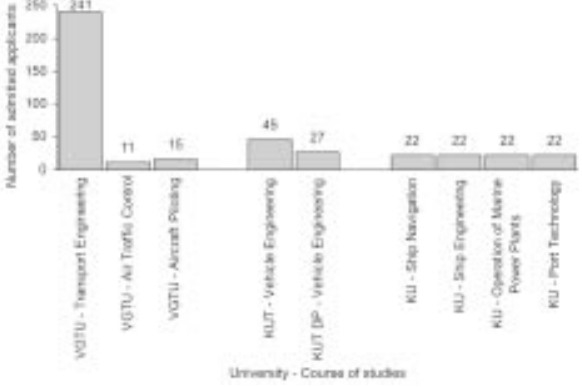
Fig 7. The number of applicants admitted to study